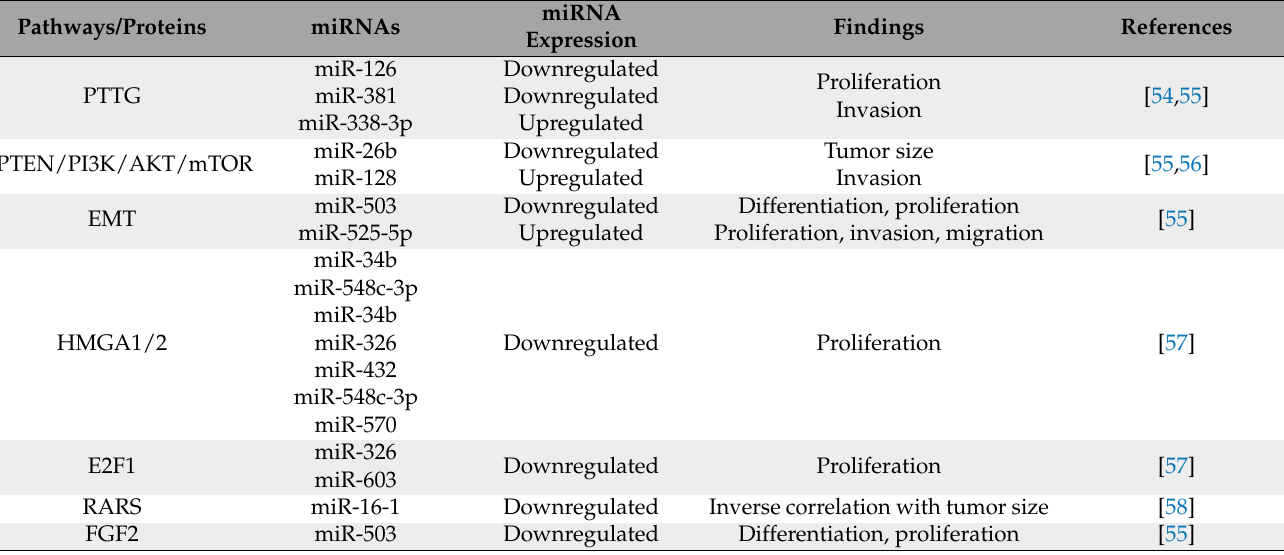
Table 1. miRNAs’ expression associated with GH-secreting pituitary adenoma tumorigenesis.